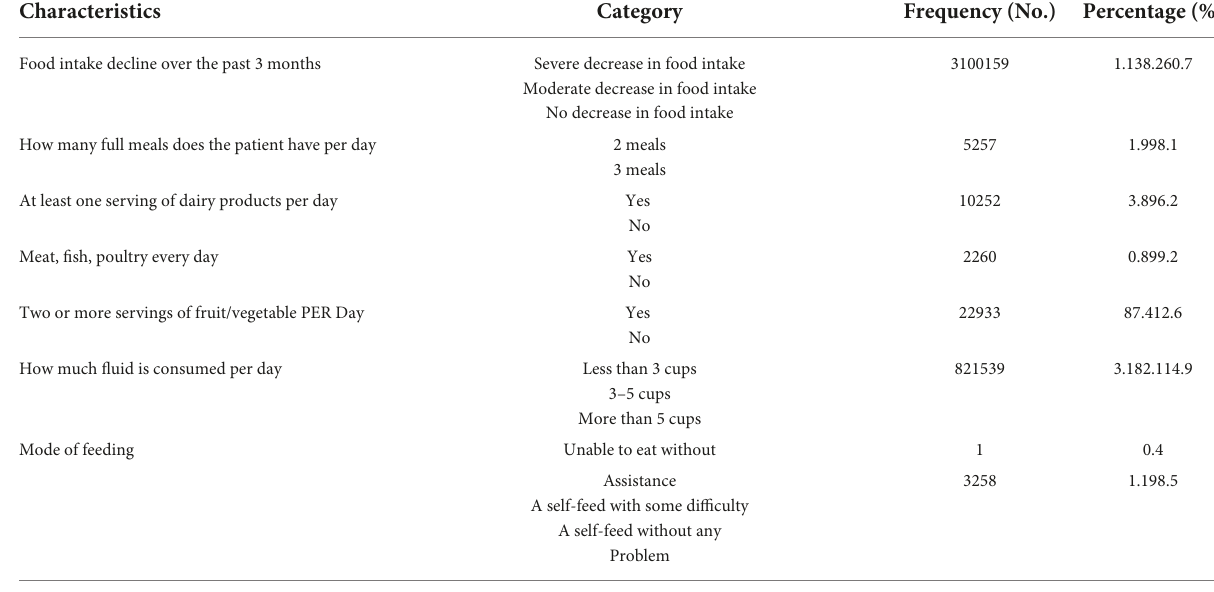
TABLE 6 Dietary assessment in older adult patients with heart failure at Cardiac Clinic, University of Gondar hospital, June 01, 2021 to October 31, 2021 (No. 262).